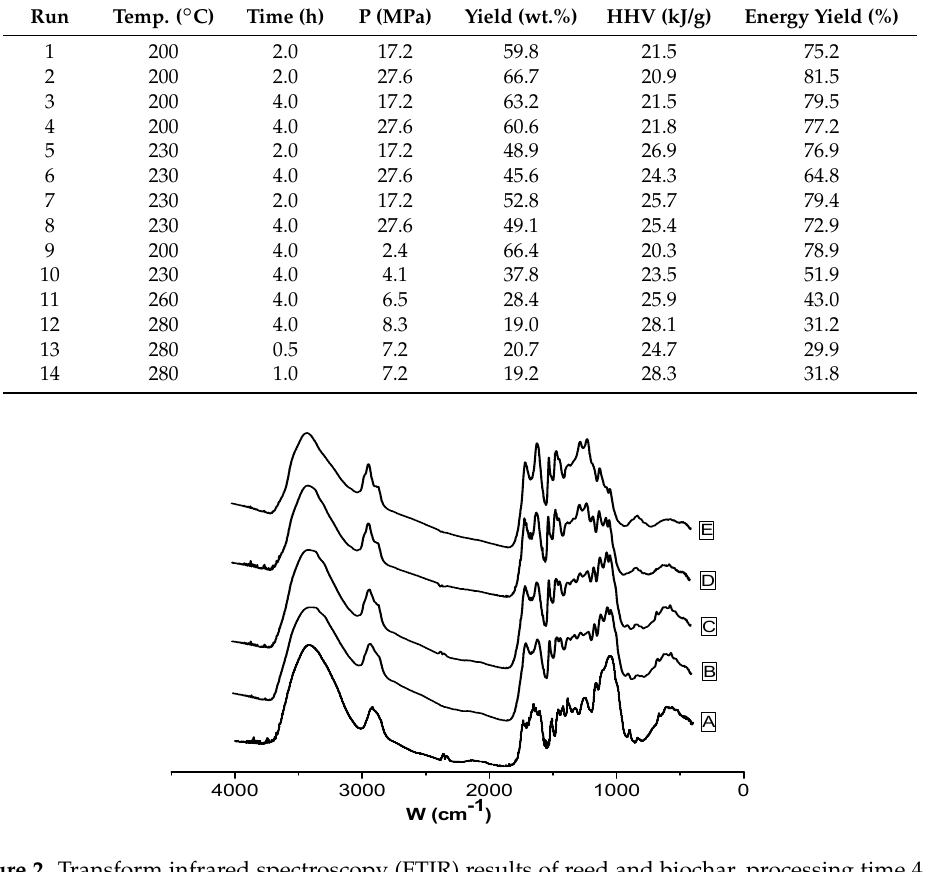
Figure 2. Transform infrared spectroscopy (FTIR) results of reed and biochar, processing time 4.0 h (A — Reed, B—200 °C, C—230 °C, D—260 °C, E—280 °C). Table 3. FRIR spectrum of the reed and biochar.